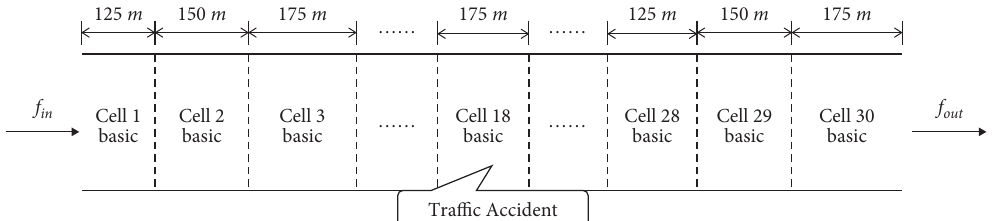
Figure 10: Mixed traffic flow simulation link.